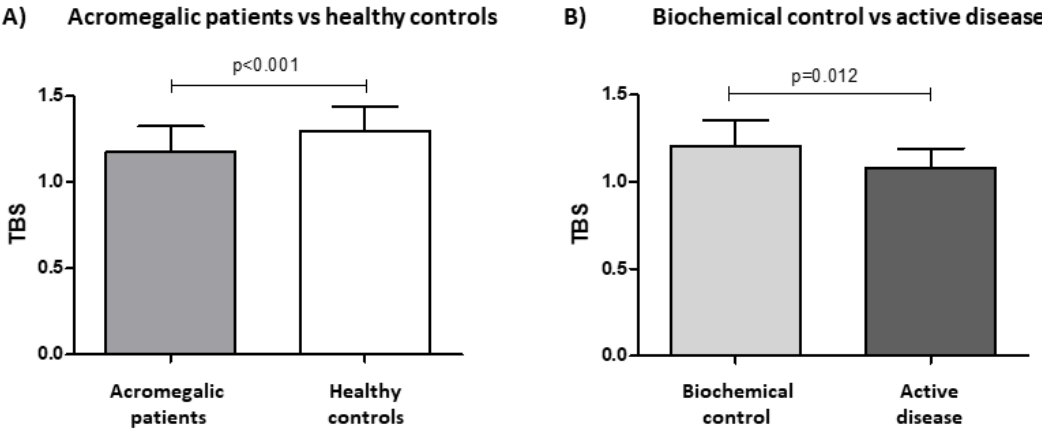
Figure 2. Mean trabecular bone score (TBS) values were significantly lower in acromegalic patients compared to age- and sex-matched healthy controls ( A ). Patients achieving biochemical control (IGF-1 <1.2 xULN) had higher TBS values compared to the uncontrolled ones ( B ). Stratifying acromegalic patients based on IGF-1 levels, we found that controlled subjects (IGF-1 < 1.2 xULN) had higher TBS values compared to the uncontrolled ones Table 3. Mean TBS (lumbar), BMD, T-score, and Z-score (all sites) in acromegalic patients and (1.21 ± 0.15 vs. 1.08 ± 0.12, p = 0.013). In this context, we observed a trend for an matched healthy controls. inverse correlation (although not statistically significant) between TBS values and sex- and age-adjusted IGF-1 levels (rho= − 0.277, p = 0.068). On the contrary, GH and ab- solute IGF-1 values did not correlate with TBS (rho = 0.03, p = 0.854 and rho= − 0.191, p = 0.213,